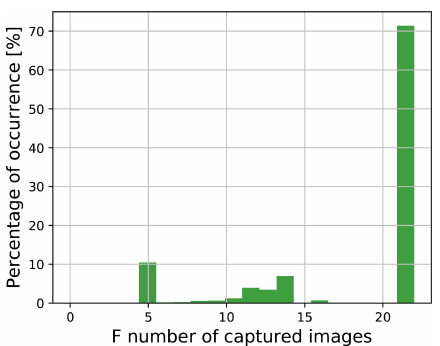
Figure 15. Distribution of F numbers of the WAHRSIS images used to derive the proposed